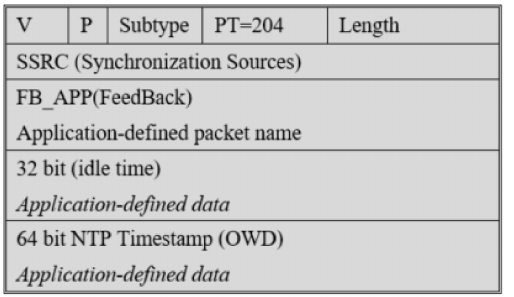
Figure 10. RTCP-APP: Application-defined RTCP packet, to carry feedback from the receiver to